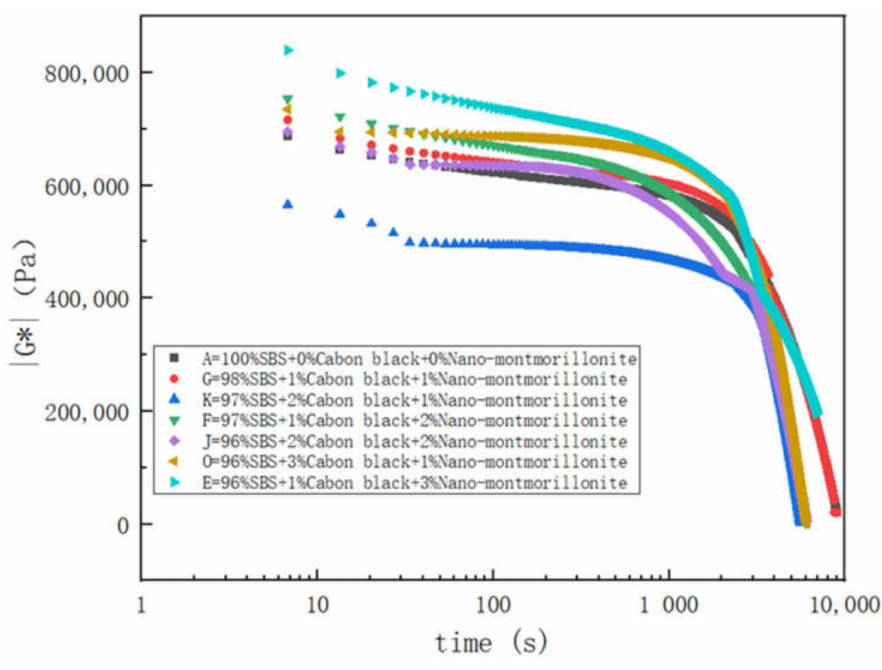
Figure 8. Fatigue curves as a function of time.